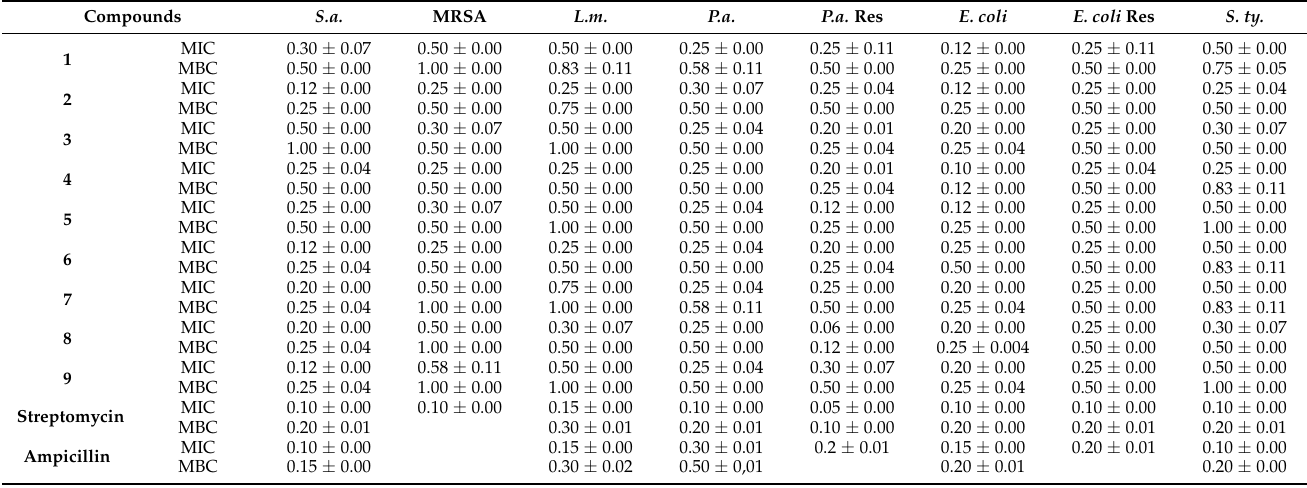
Table 3. Antibacterial activity of compounds (MIC and MBC in